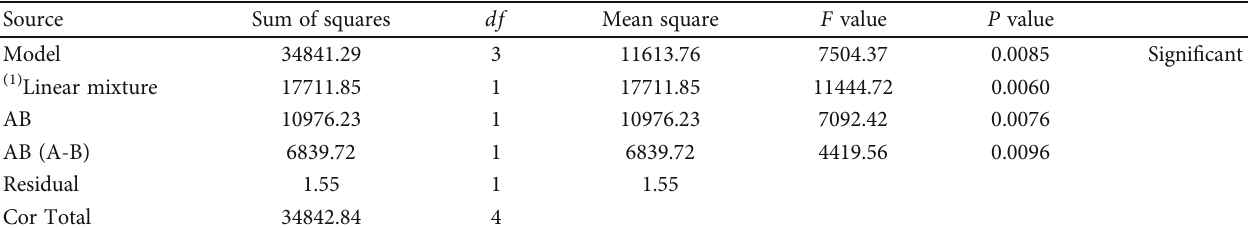
Table 3: Compressive strength.